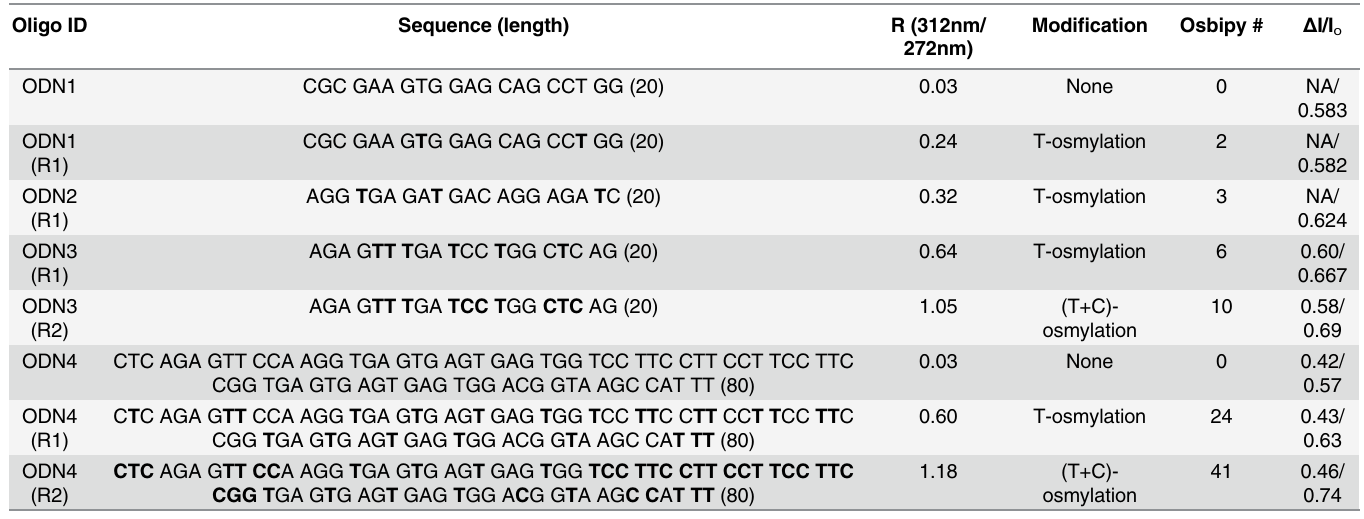
Table 1. List of oligo sequences, osmylation levels, and current blockades. Oligo